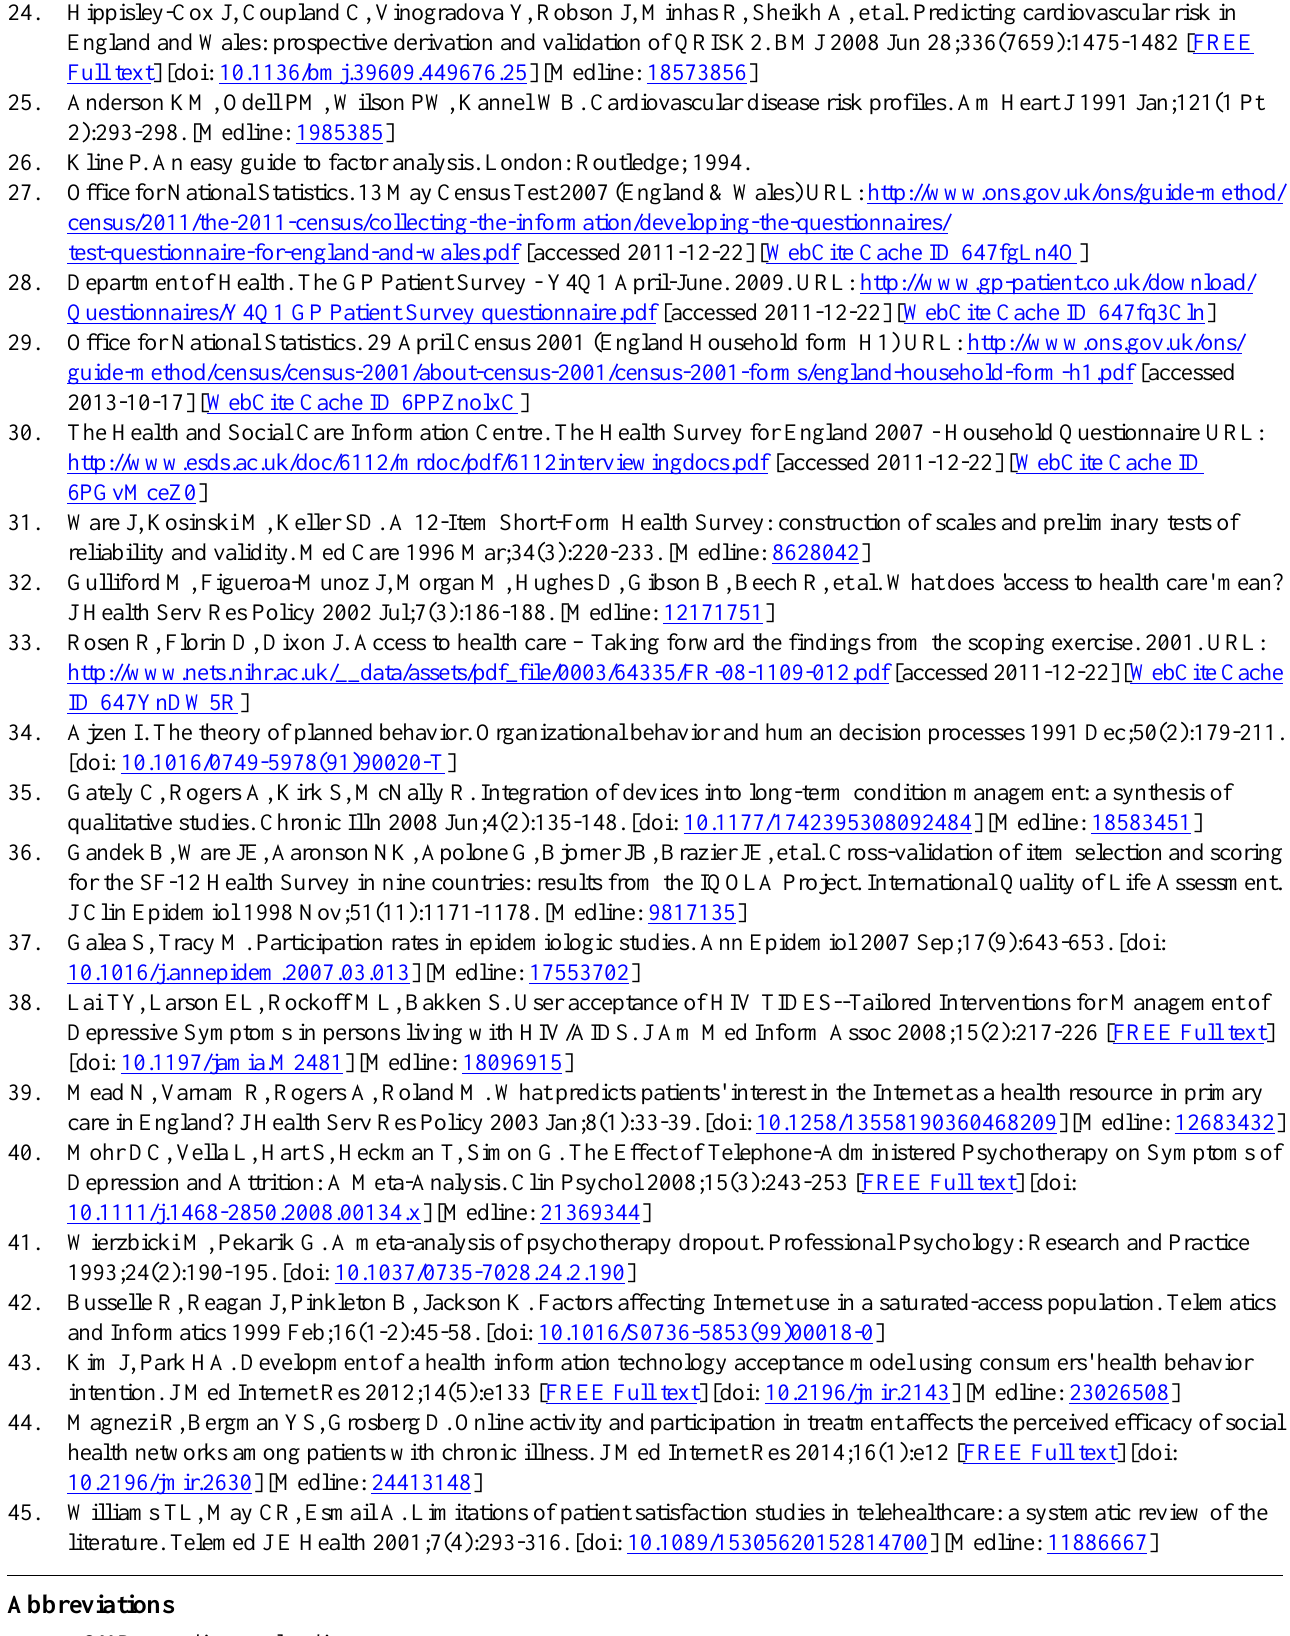
MCS: Mental Component Summary NHS: National Health Service